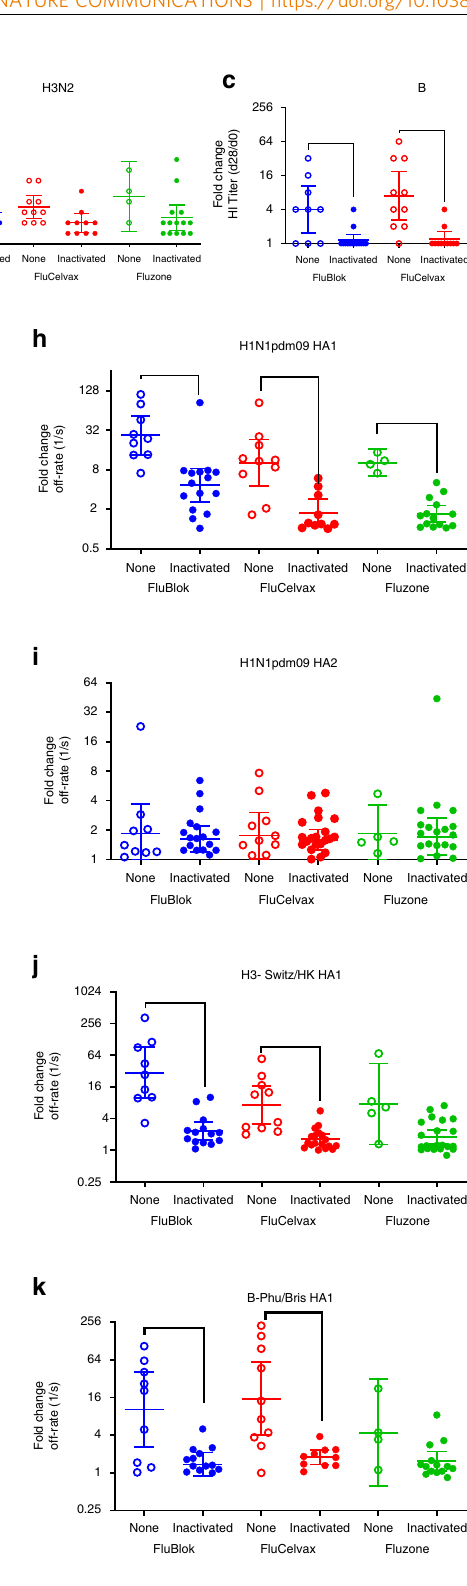
correlation between high-af fi nity antibodies against the HA1 domain of H7N7 following vaccination and reduction in lung viral loads after challenge with either H7N7 or H7N9 highly pathogenic avian in fl uenza viruses 22 . Furthermore, high titers of low avidity antibodies in infected individuals were associated with severe H1N1pdm09 disease 32 .